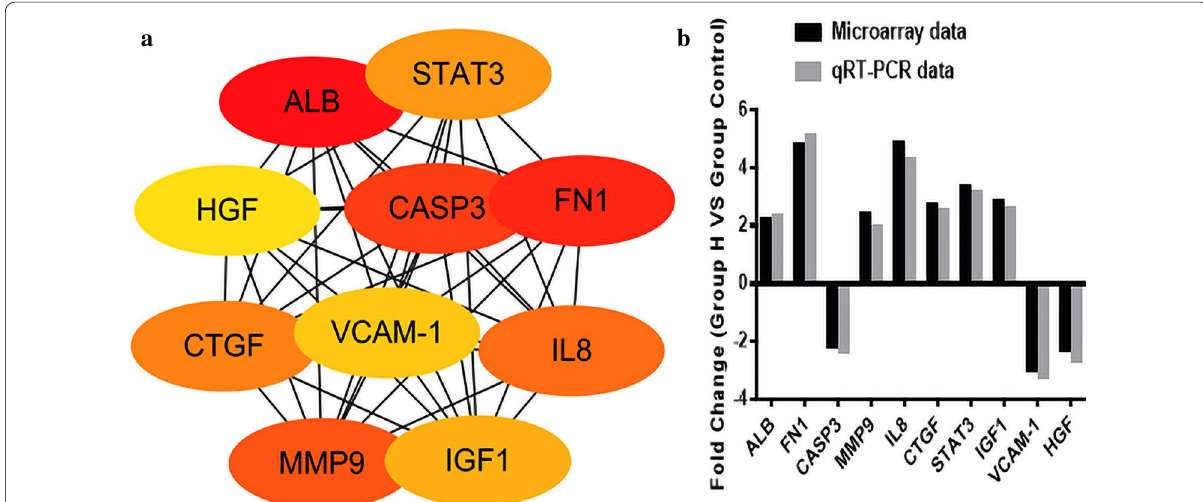
Fig. 5 The validation of top 10 hub genes. a The more forward ranking is represented by a redder color. b The heights of the columns in the chart represent FCs. p < 0.05 was considered to indicate a statistically significant